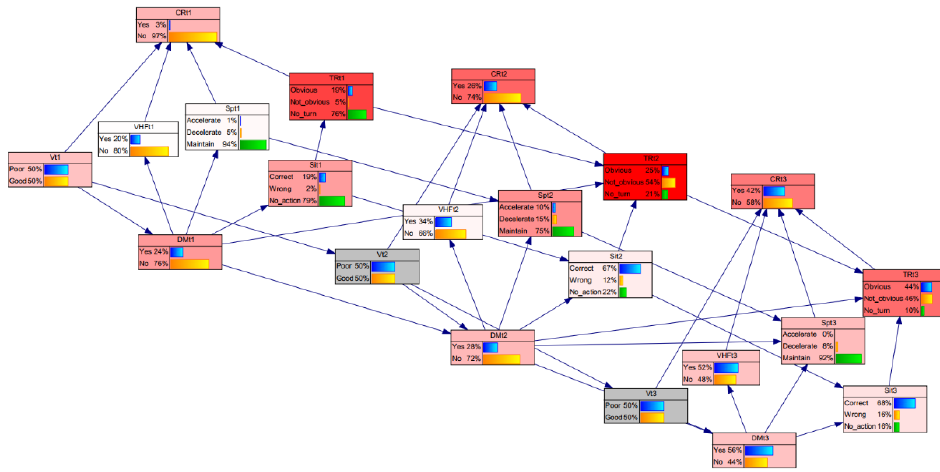
Figure 12. Node influence degree under the high collision risk (CRt 3 ) in the DBN model.